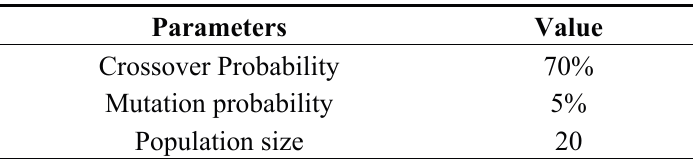
Table 1. Parameters of genetic